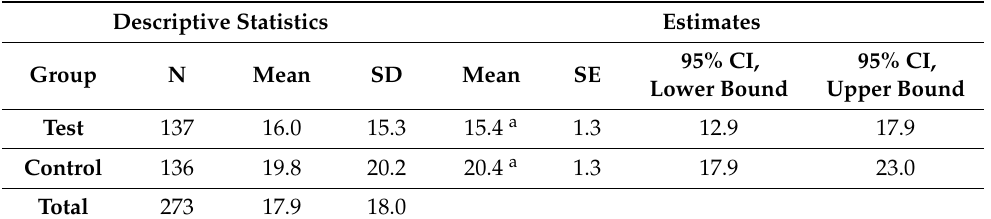
Table 3. Descriptive statistics and estimates of the OHIP-49 score at endpoint (dependent